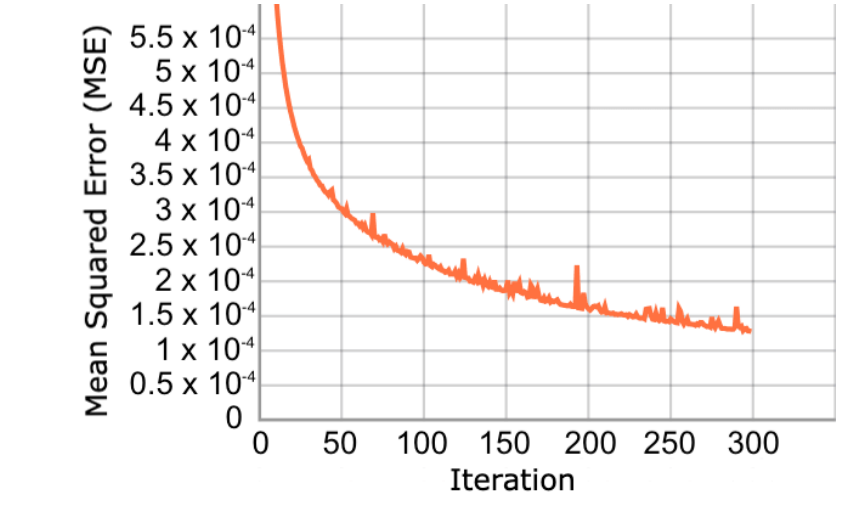
Figure 6. Evolution of validation cost function. The function decreases by minimizing the reconstruc- tion error of the trajectories in the validation